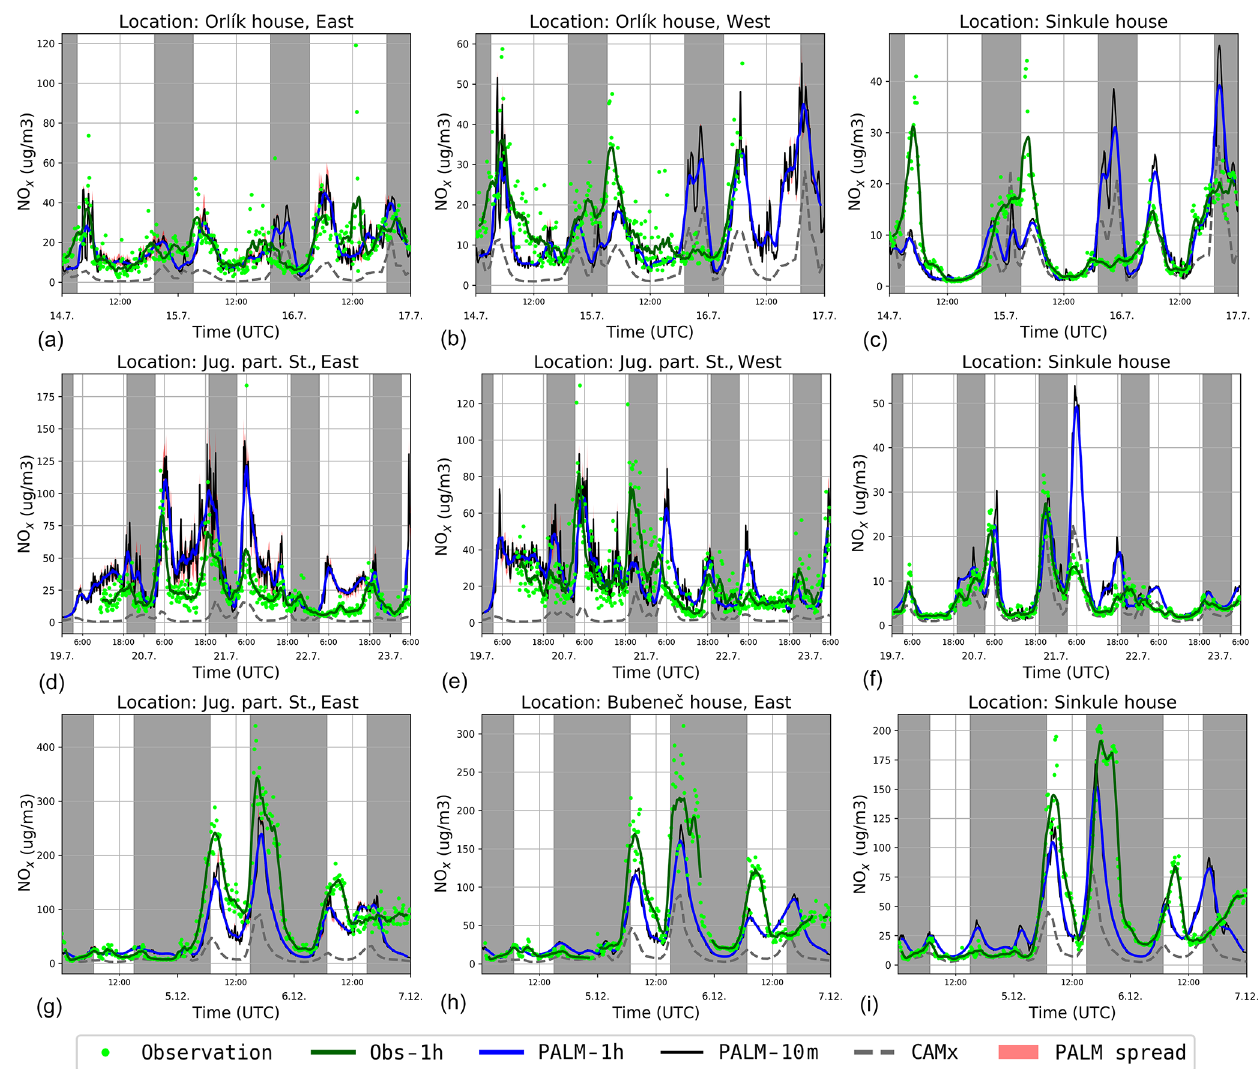
Figure 29. Street canyon NO x concentrations at 3.9m (Sinkule house) and 4.6m (other locations) for the summer e1 (a, b, c) , summer e2 (d, e, f) , and winter e3 (g, h, i) episodes. Observations are shown as 10min averages (green dots) and moving 1h averages (green line). PALM simulations are shown as moving 1h averages (blue line), 10min averages (black line), and the interval between the smallest and the largest 10min average among the neighbouring grid points (red band). The grey dashed line denotes the CAMx 1h concentration for the lowest level (lowest 50m above ground) at the closest CAMx grid point. The grey shaded areas indicate